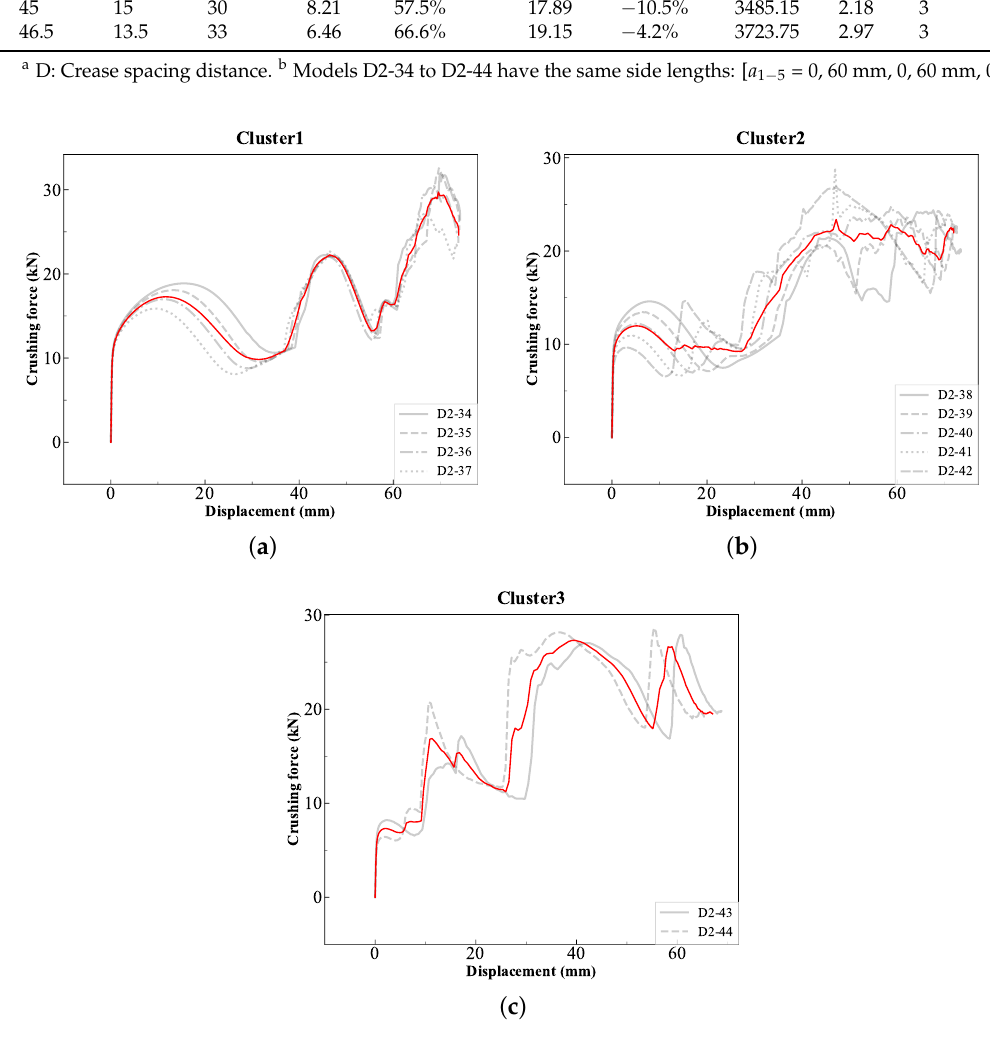
Figure 15. Clustering results of models D2-34 ∼ D2-44: ( a ) Cluster 1; ( b ) Cluster 2; ( c ) Cluster 3. The red line in each picture is the curve for each cluster’s center of